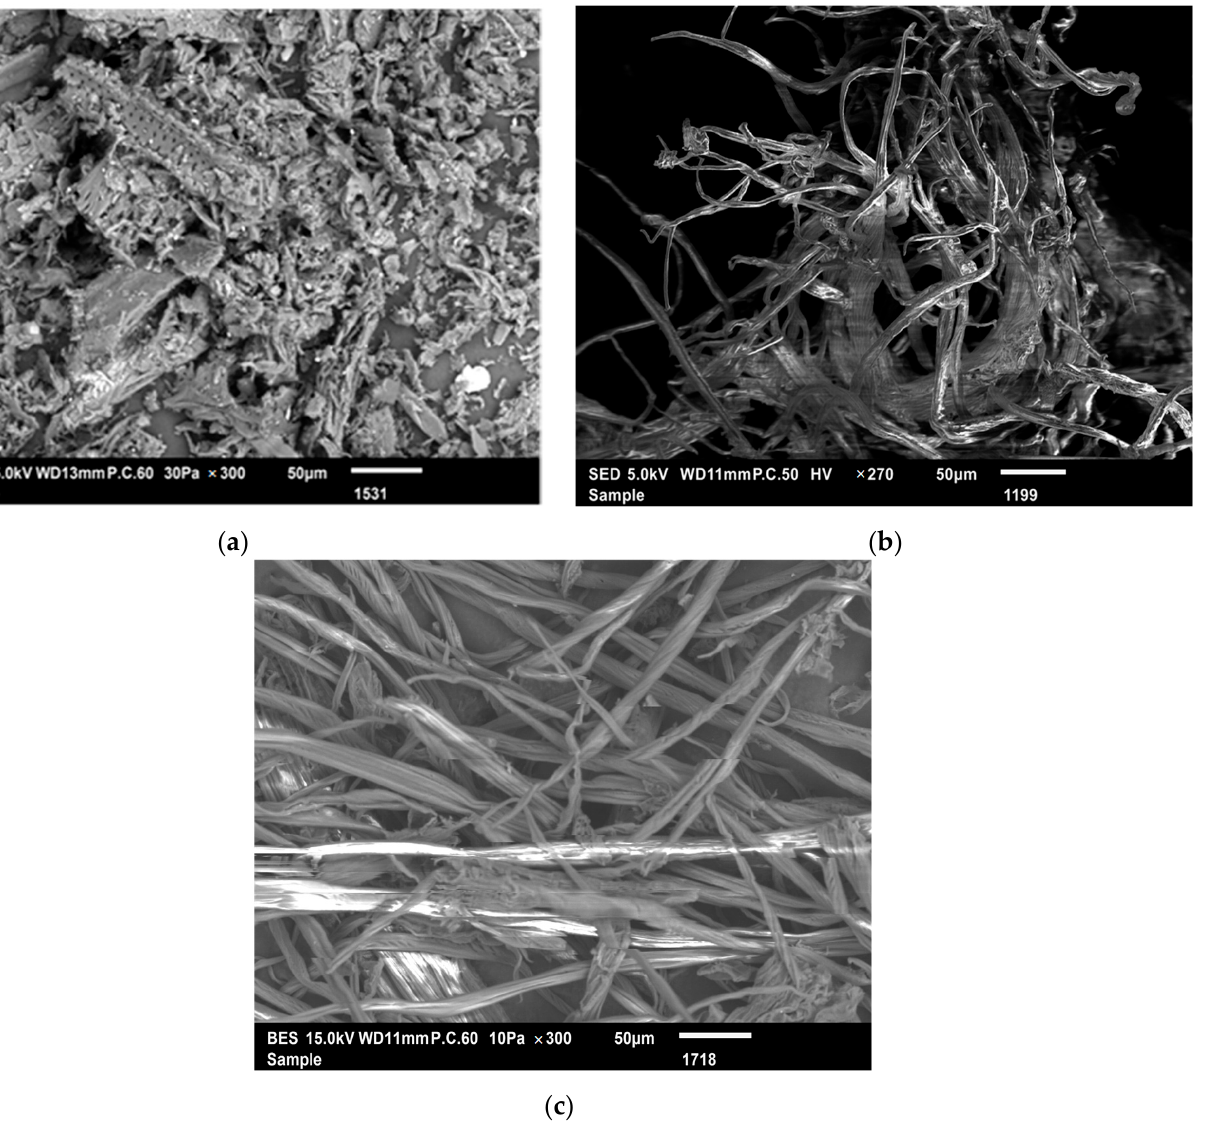
Figure 2. SEM observations of raw material ( a ), delignified fibers ( b ), and delignified, bleached fibers ( c ).